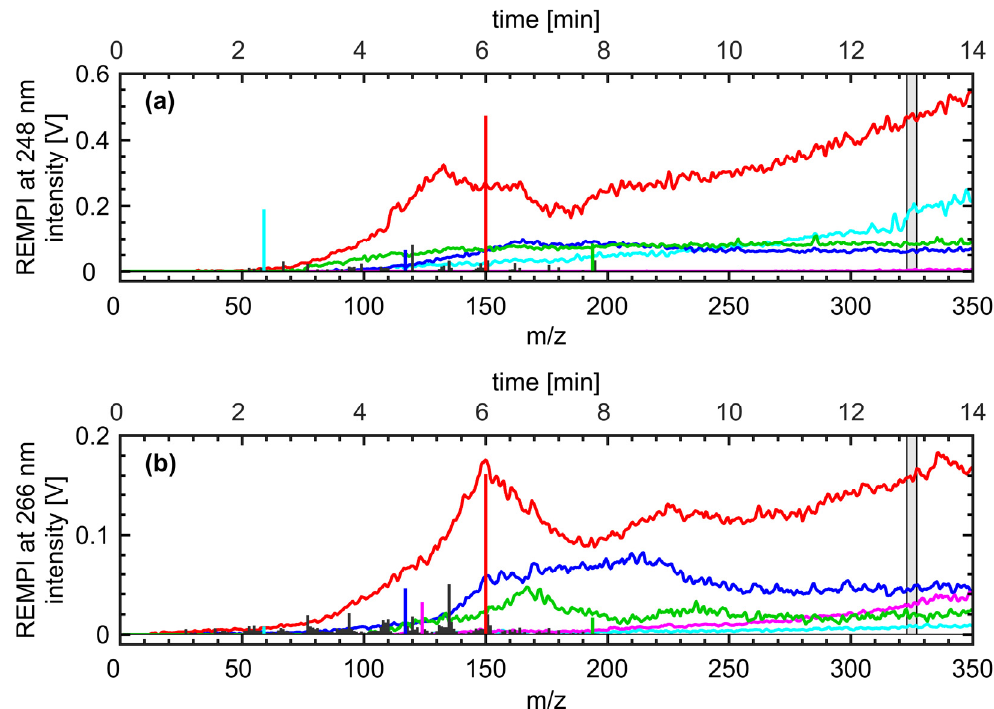
Figure 4. Combined average mass spectrum (vertical bars referring to m / z ) at 13 min (average over grey shaded area) and mass traces of selected compounds ( m / z 59 trimethylamine (cyan), m / z 117 indole (blue), m / z 124 guaiacol (magenta), m / z 150 vinylguaiacol (red), m / z 194 ca ff eine (green) referring to time) for REMPI-TOFMS measurements at ( a ) 248 nm and ( b ) 266 nm. In both mass spectra, vinylguaiacol denotes the base peak. However, REMPI at 248 nm is more sensitive than REMPI at 266 nm for